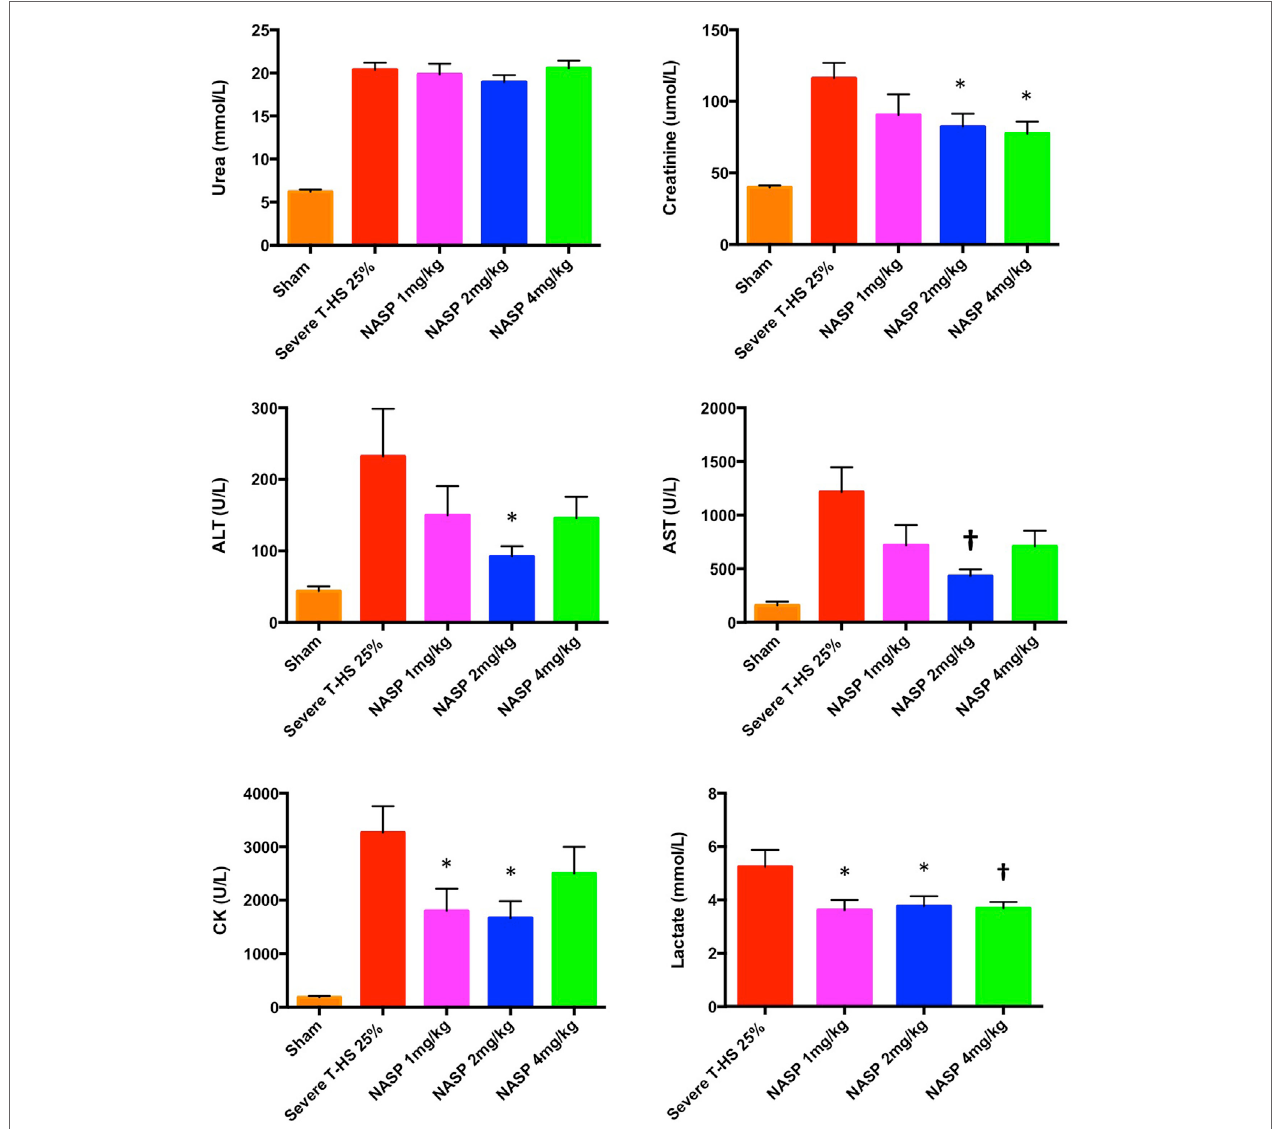
FigUre 12 | Other organ injury markers at 6 h. Urea: there was no detectable difference in urea concentration with an increasing dose of nucleic acid scavenging polymer (NASP) (hexadimethrine bromide) used in severe T-HS 25%. Creatinine: renal protection was evident with NASP 2 and 4 mg/kg doses. Alanine aminotransferase (ALT) and aspartate aminotransferase (AST): there was a significant attenuation of liver injury evident with NASP 2 mg/kg dosing. Creatine kinase (CK): there was a significant attenuation of muscle injury with both NASP 1 and 2 mg/kg doses. Lactate: there was a significant reduction in 6 h lactate with all three doses NASP used. * denotes p < 0.05, † denotes p < 0.01 was untreated severe T-HS 25%, t -tests. n = 12–18 animals per group. Mean values with SEM bars shown. Overall, the NASP 2 mg/kg group produced the most consistent multiple organ protection in severe T-HS